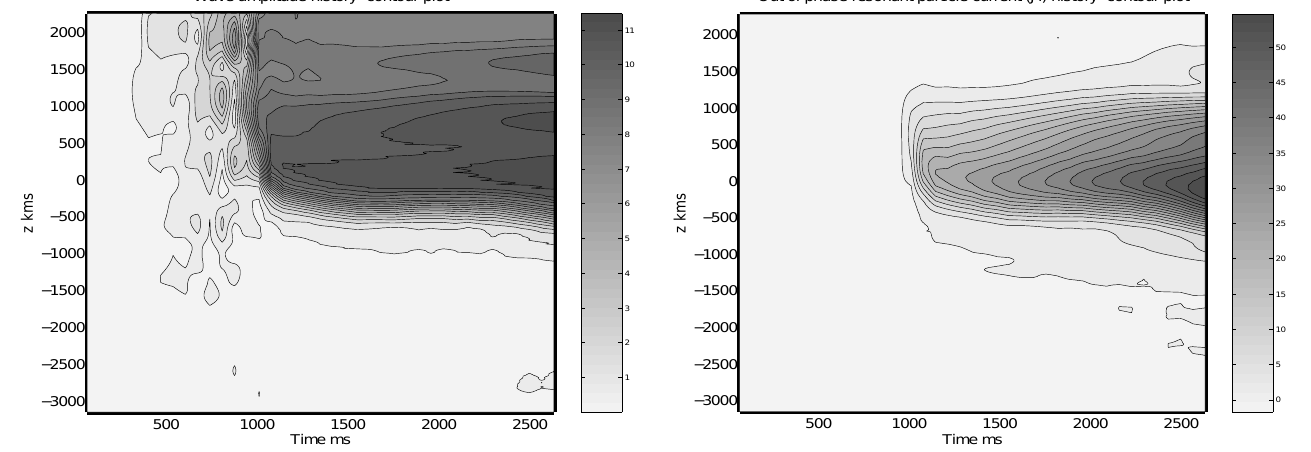
Fig. 10. Run 1. Exit wave amplitude (pT) history of the entire simulation as a contour plot in the z , t plane. Note the stable quasi- static envelope of the riser GR. Units of the grey scale are arbitrary.